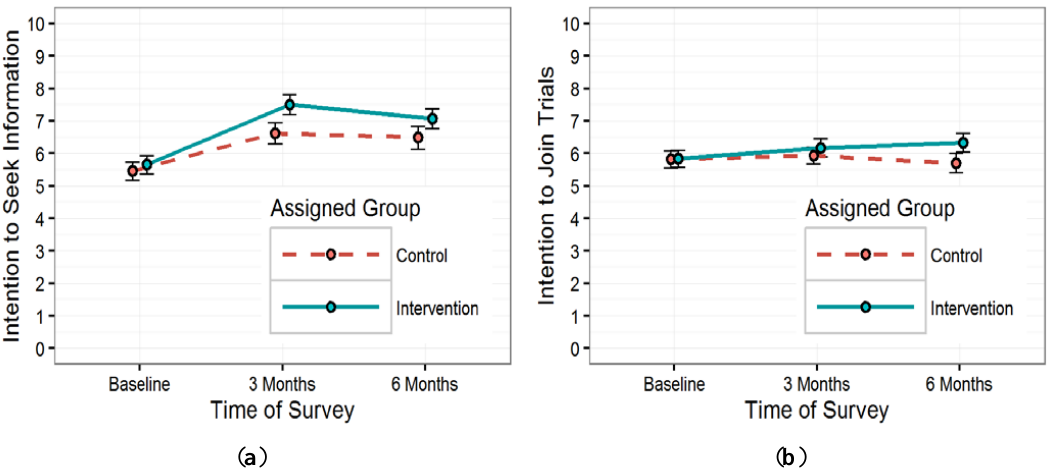
Figure 1. ( a ) Change in mean intention to seek information over time; ( b ) change in mean intention to join over time.